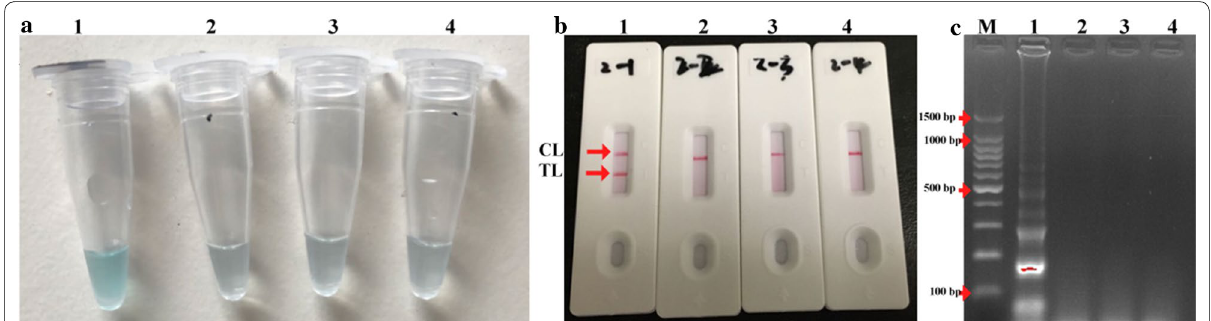
Fig. 2 Confirmation and detection of MP-LAMP amplification products. a Amplification products of MP-LAMP assay were visually detected by colorimetric indicators. b LFB applied for visual identification of MP-LAMP products. c Amplification products of MP-LAMP assay were detected by agarose gel electrophoresis. Tube/biosensor/lane: (1) positive products of MP; (2) negative control of Streptococcus pneumoniae ; (3) negative control of Staphylococcus aureus ; (4) blank control of double distilled